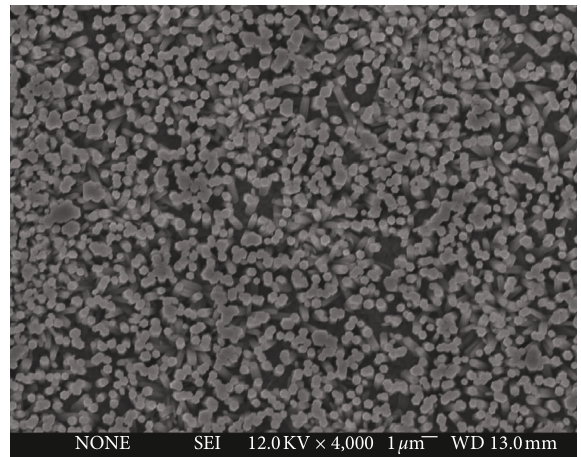
Figure 2: SEM image of ZnO nanorods grown on p-Si substrate.